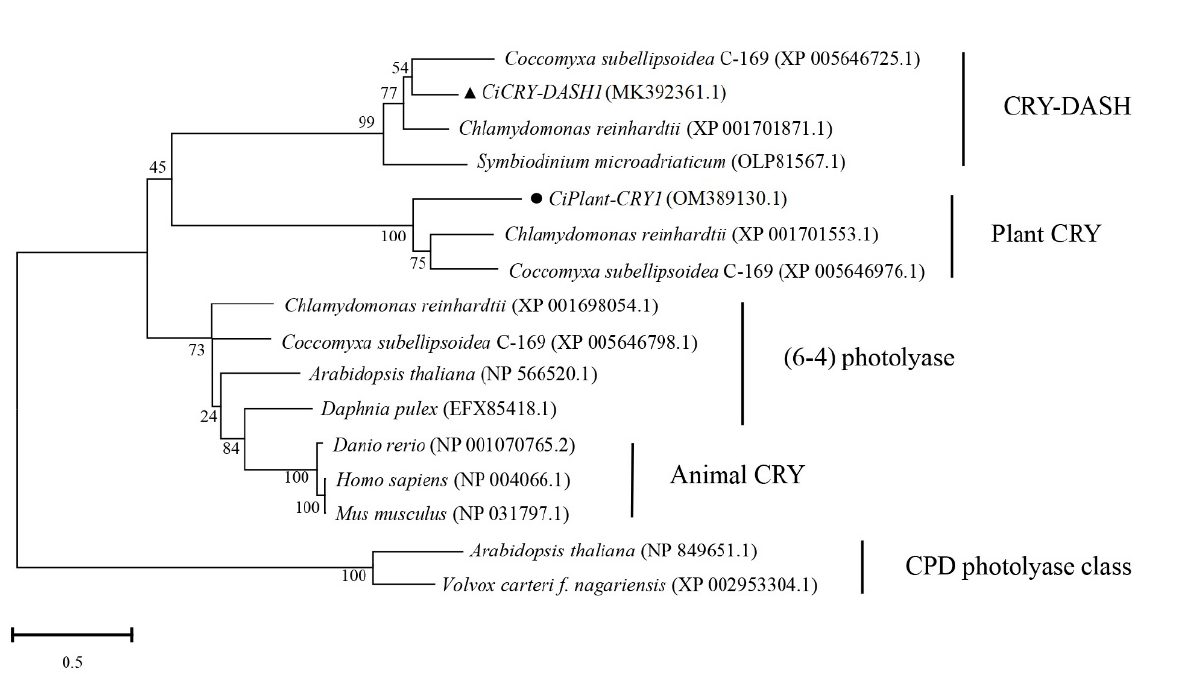
Figure 2. Phylogenetic tree for CiPlant-CRY1 and related cryptochrome/photolyase family based on amino acid sequences. Numbers at nodes indicate levels of bootstrap support (%) based on a neighbor-joining analysis. The bootstrap test of the tree was performed with 1000 replications.